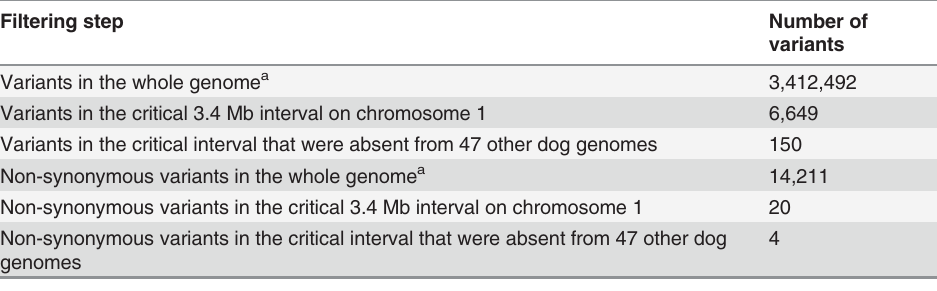
Table 1. Variants detected by whole genome re-sequencing of an affected